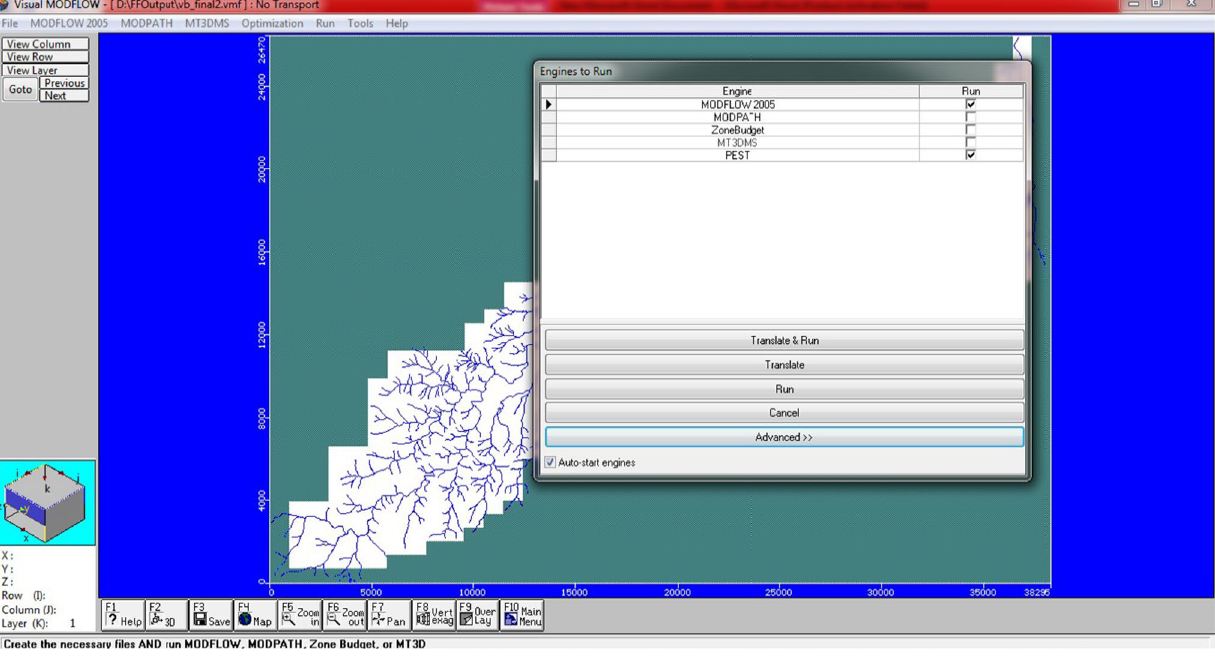
Fig. 6 Engine to run